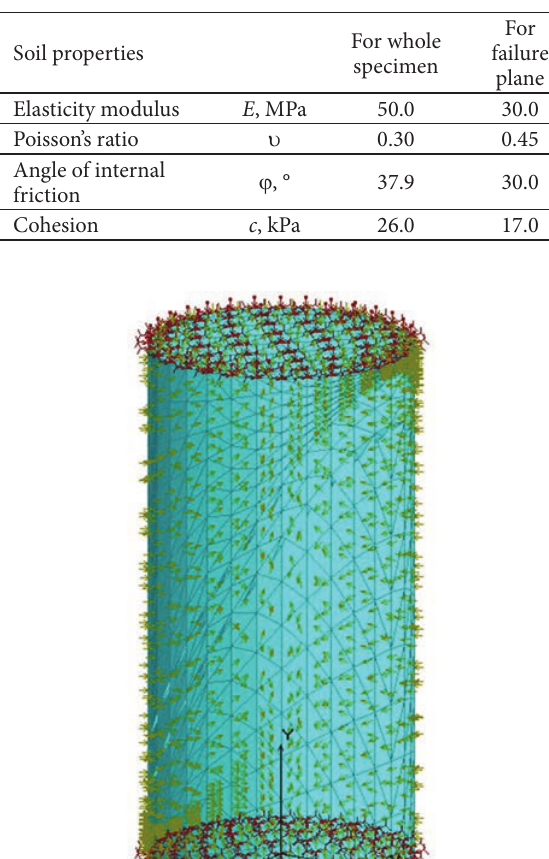
For whole specimen